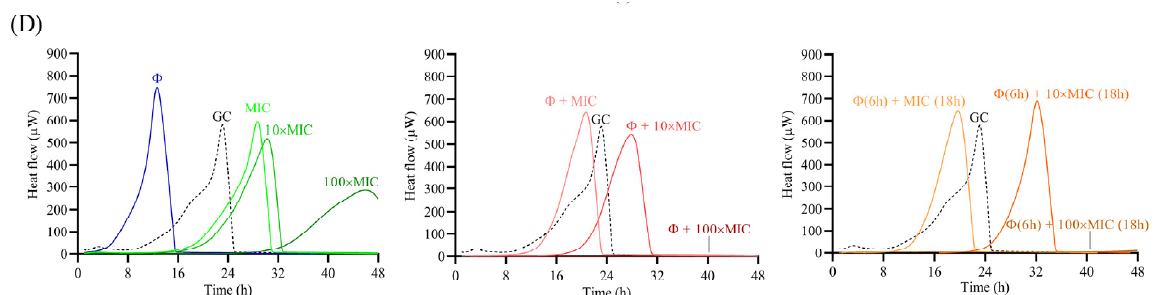
Figure 6. Calorimetric curves. Monitored heat flow ( μ W) of S. maltophilia ( A ) STM-1, ( B ) STM-19, ( C ) STM-33 and ( D ) STM-38 biofilms treated with CUB19 ( Φ at 10 8 PFU/mL) or levofloxacin at different concentrations (1 × , 10 × or 100 × MIC) as monotherapy (left column), or by simultaneous (middle column) and staggered (right column) phage-antibiotic combinations ( Φ + levofloxacin). Each curve shows the heat flow produced over time by viable bacteria in the biofilm after 24 h of treatment. GC represents the growth control sample not exposed to any antimicrobials. Data of a representative experiment are reported.